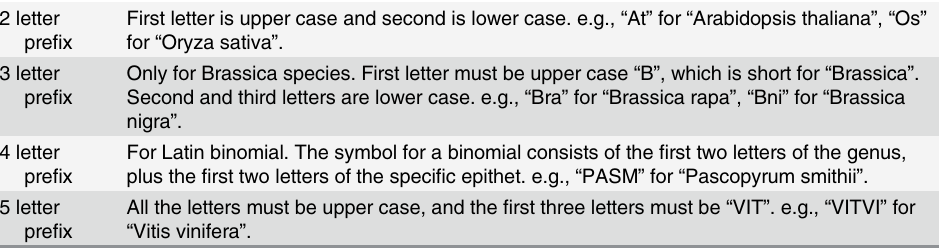
Table 2. Plant species prefix